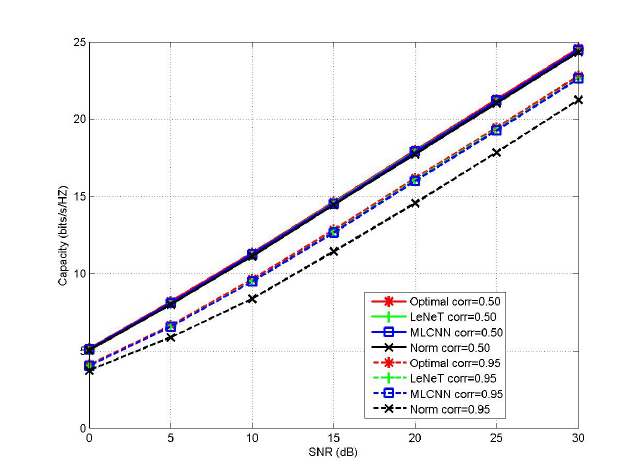
Figure 3. Channel capacity performance comparison between MLCNN-aided AS, LeNet-based AS and